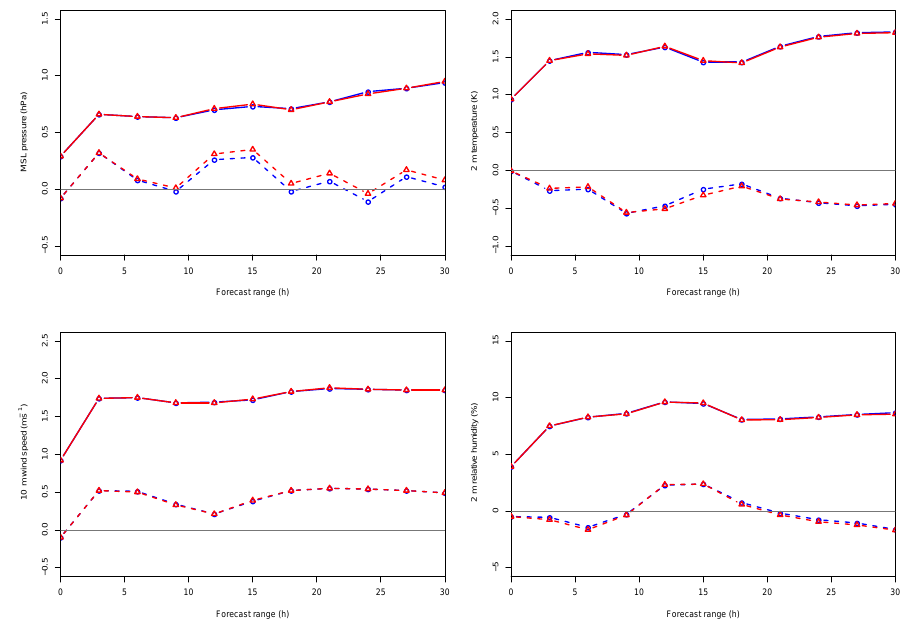
Figure 2. RMSE (solid line) and bias (dashed line) over the period 1–30 November 2014, for REF (blue circles) and FCI (red